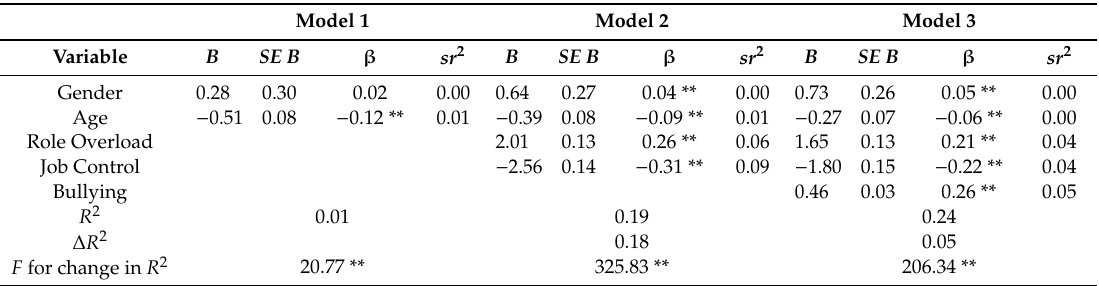
Table 2. Summary of hierarchical regression analysis for variables predicting psychological distress ( n = 3020).